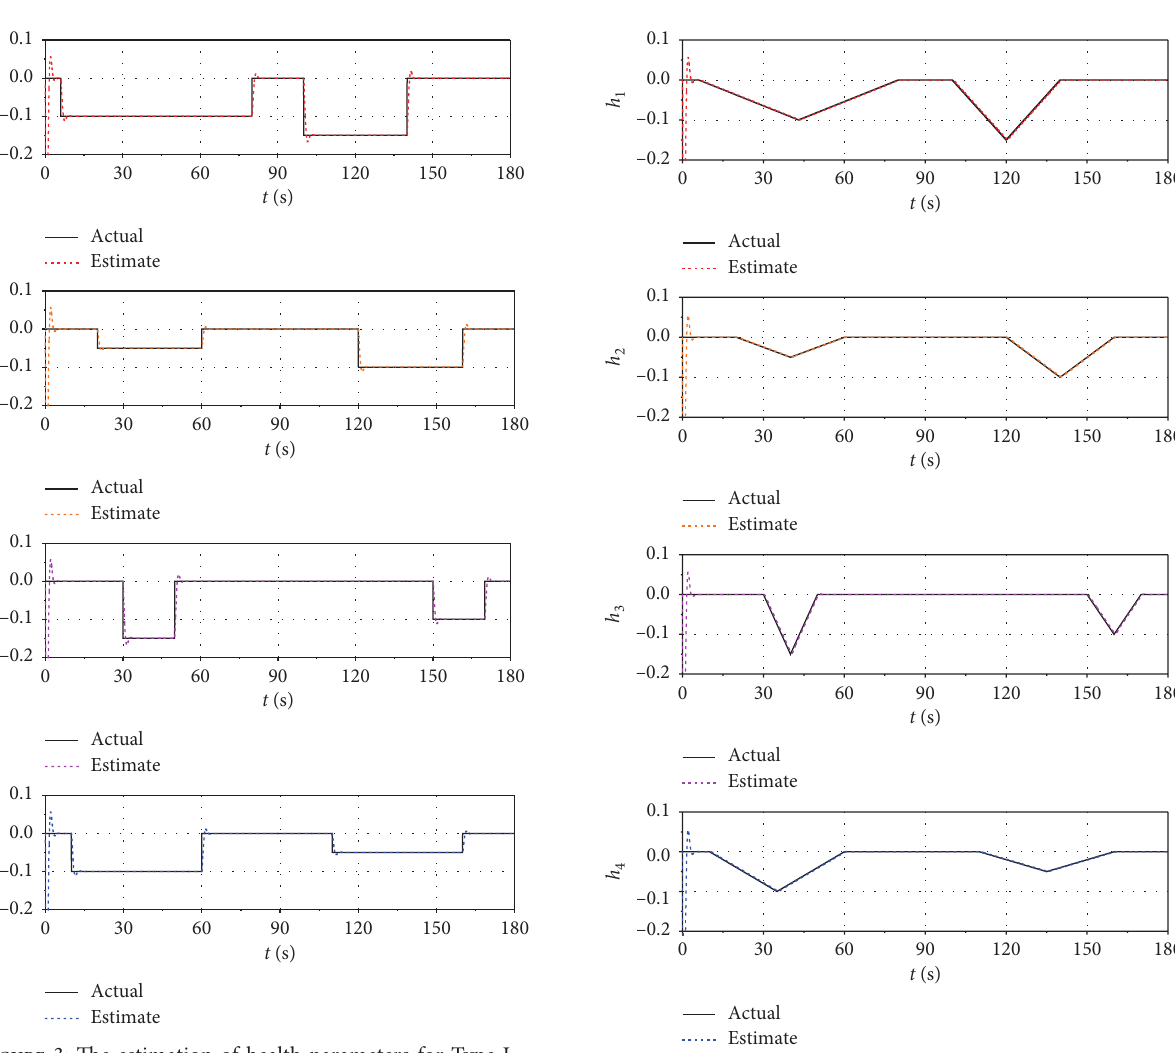
Figure 4: The estimation of health parameters for Type